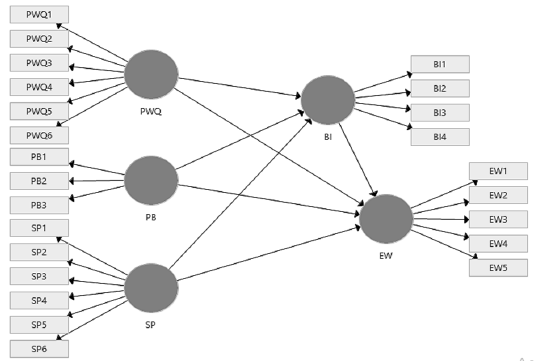
Fig. 1. Theoretical